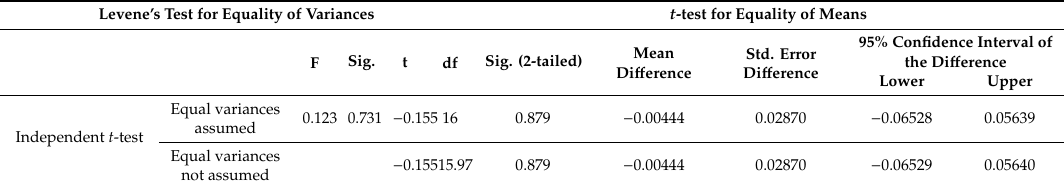
Table 12. Levene’s test for testing the equality of variances.